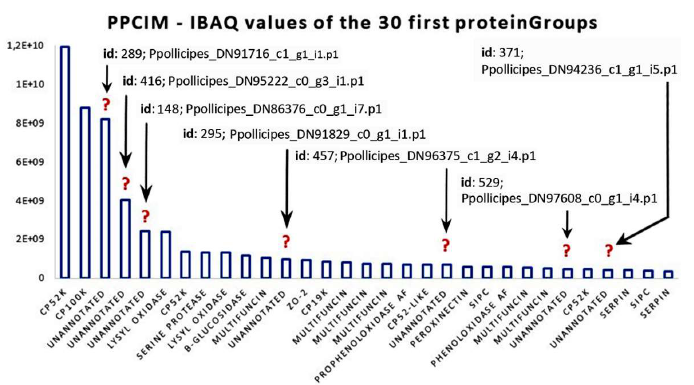
Figure 5. The 30 most expressed proteins in the cement proteome (PPCIM) of the barnacle Pollicipes pollicipes , based on the absolute protein abundance. The expression of the 30 most expressed proteins (X-axis) is represented by the intensity-based absolute quantification (iBAQ) score (Y-axis) calculated by MaxQuant. Question marks indicate those highly expressed proteins with no homology (named as unannotated in X-axis) found in the cement proteome, their proteinGroup id , and the name of the corresponding leading protein.